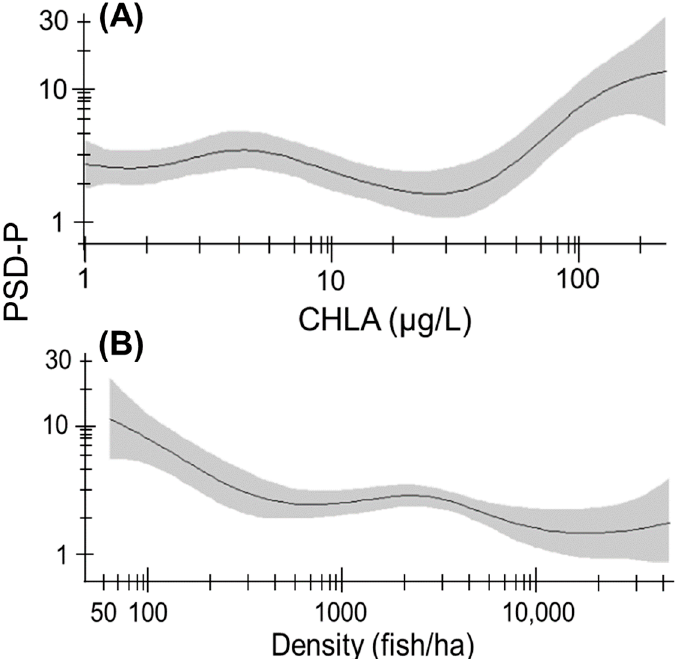
Figure 6. Generalized additive model relating proportional size distribution of preferred-length Bluegills (PSD-P) to ( A ) chlorophyll- a concentration (CHLA, μ g/L, p < 0.001) and ( B ) Bluegill density (fish/ha, p < 0.001) in Florida lakes. Shaded areas are 95% confidence intervals.